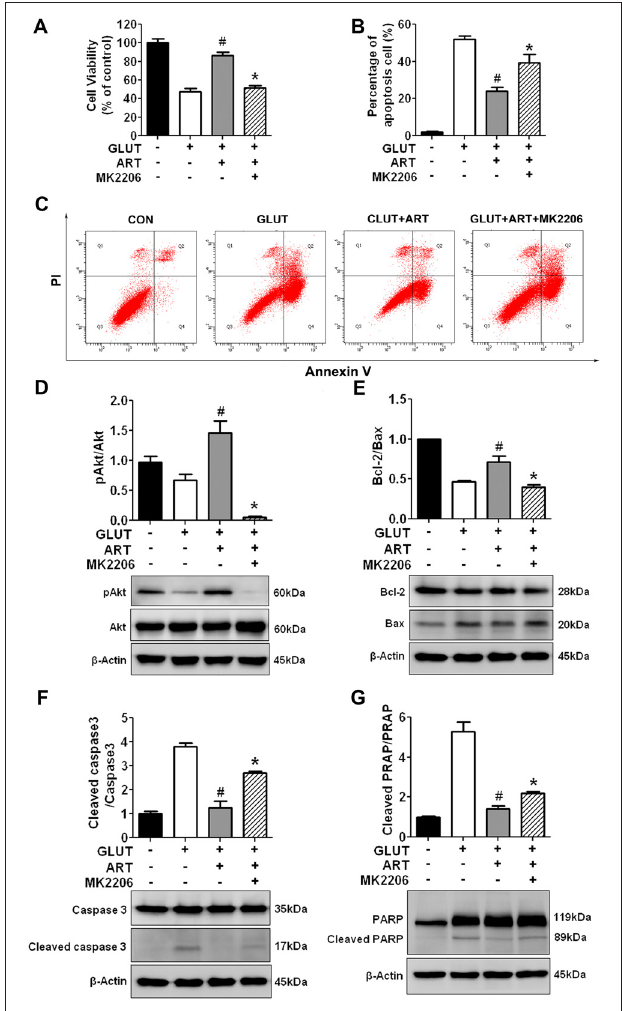
FIGURE 6 | Akt pathway inhibitor MK2206 abolished the protective effect of artemisinin against glutamate insult in HT-22 cells. (A) Calcein-AM cell viability assay demonstrated that MK2206 attenuated the protective effects of artemisinin against glutamate-induced cell death. (B,C) Annexin V/PI flow cytometry analysis showed that MK2206 abolished the protective effect of artemisinin against glutamate-induced apoptosis. (D,E) Western blots analysis indicated that MK2206 attenuated artemisinin-induced increased of pAkt/Akt and Bcl-2/Bax ratio. (F,G) Western blots demonstrated that MK2206 abolished artemisinin-induced decrease of cleaved caspase-3 and cleaved PRAP expression in HT-22 cells. The antibodies in Figures 6E,F were incubated in the same gel. Therefore, they had the same reference. # p < 0.05 vs. CLUT group, ∗ p < 0.05 vs. GLUT+ART